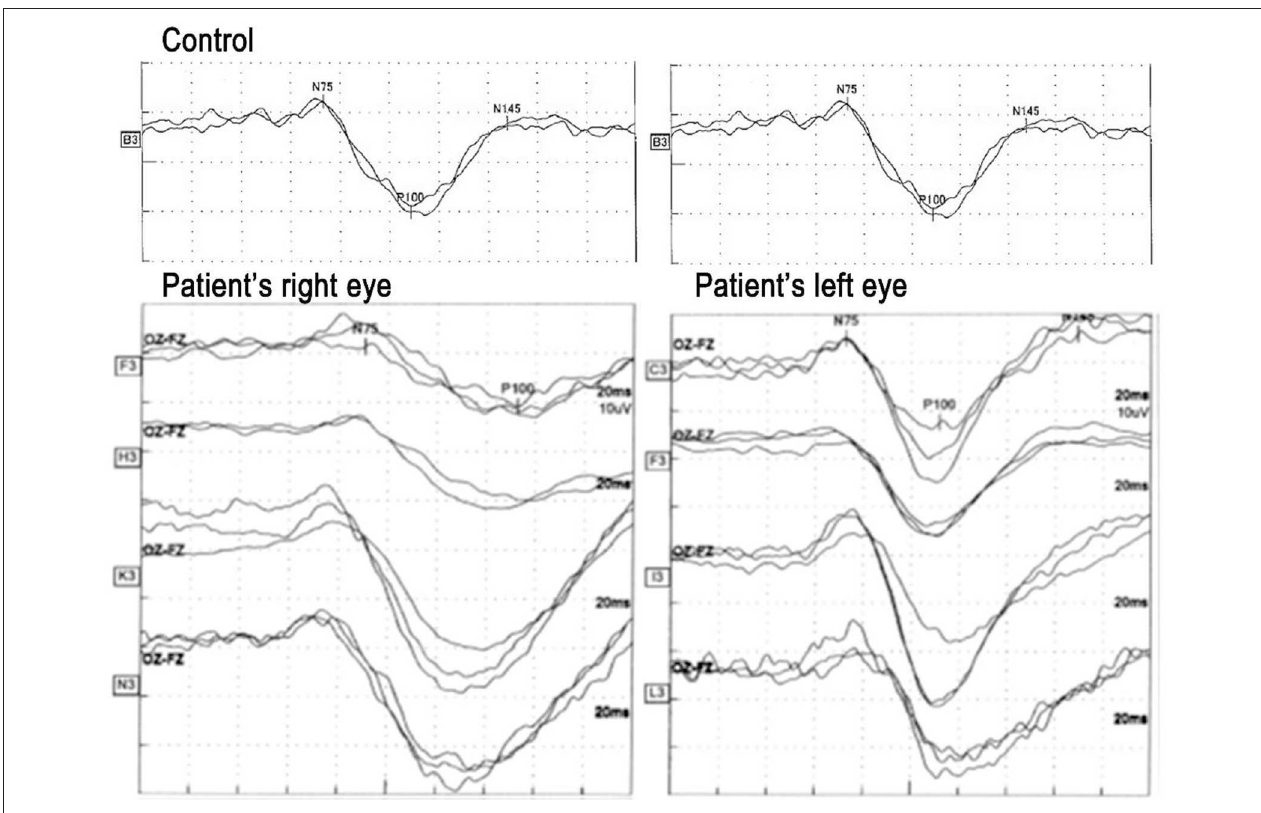
FIGURE 3 | Pattern visual evoked potentials (pVEPs) recorded several times during the experimental period. Left pVEPs elicited by stimulating the right eye and that elicited by stimulating the left eye. Top pVEPs recorded on day 14 when visual acuity was 1.0, second row: on day 21 when visual acuity was 1.2, third row: on day 109 when visual acuity was 1.2, and bottom: on day 305 when visual acuity was 1.2. The implicit time of N75 was prolonged until day 21 in the right eye compared to the left eye, and thereafter it seems to normalize and stable for almost 1 year. On the other hand, the implicit time of the P100 component was prolonged in the right eye compared to the left eye throughout of the following period. The implicit time in the right eye became shorter with time and stabilized between the day 109 and 305 while the implicit time in the left eye was stable during entire period. An example from normal control is shown in the top.